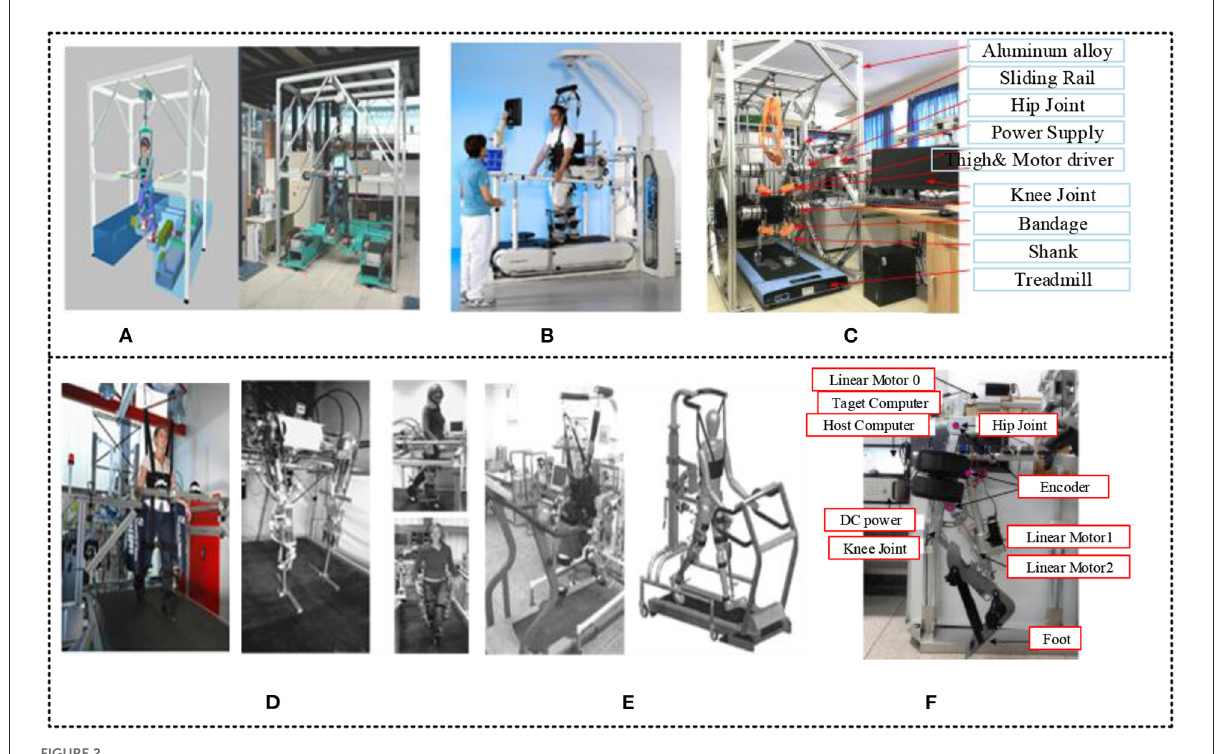
FIGURE2 (A) A novel haptic device by Fraunhofer Institute IPK, Berlin, Germany, Department of Automation and Robotics, the Haptic Walker. This haptic locomotion interface is skilled at reproducing slow and smooth trajectories, simulating walking on the floor and up and down the stairs. It is